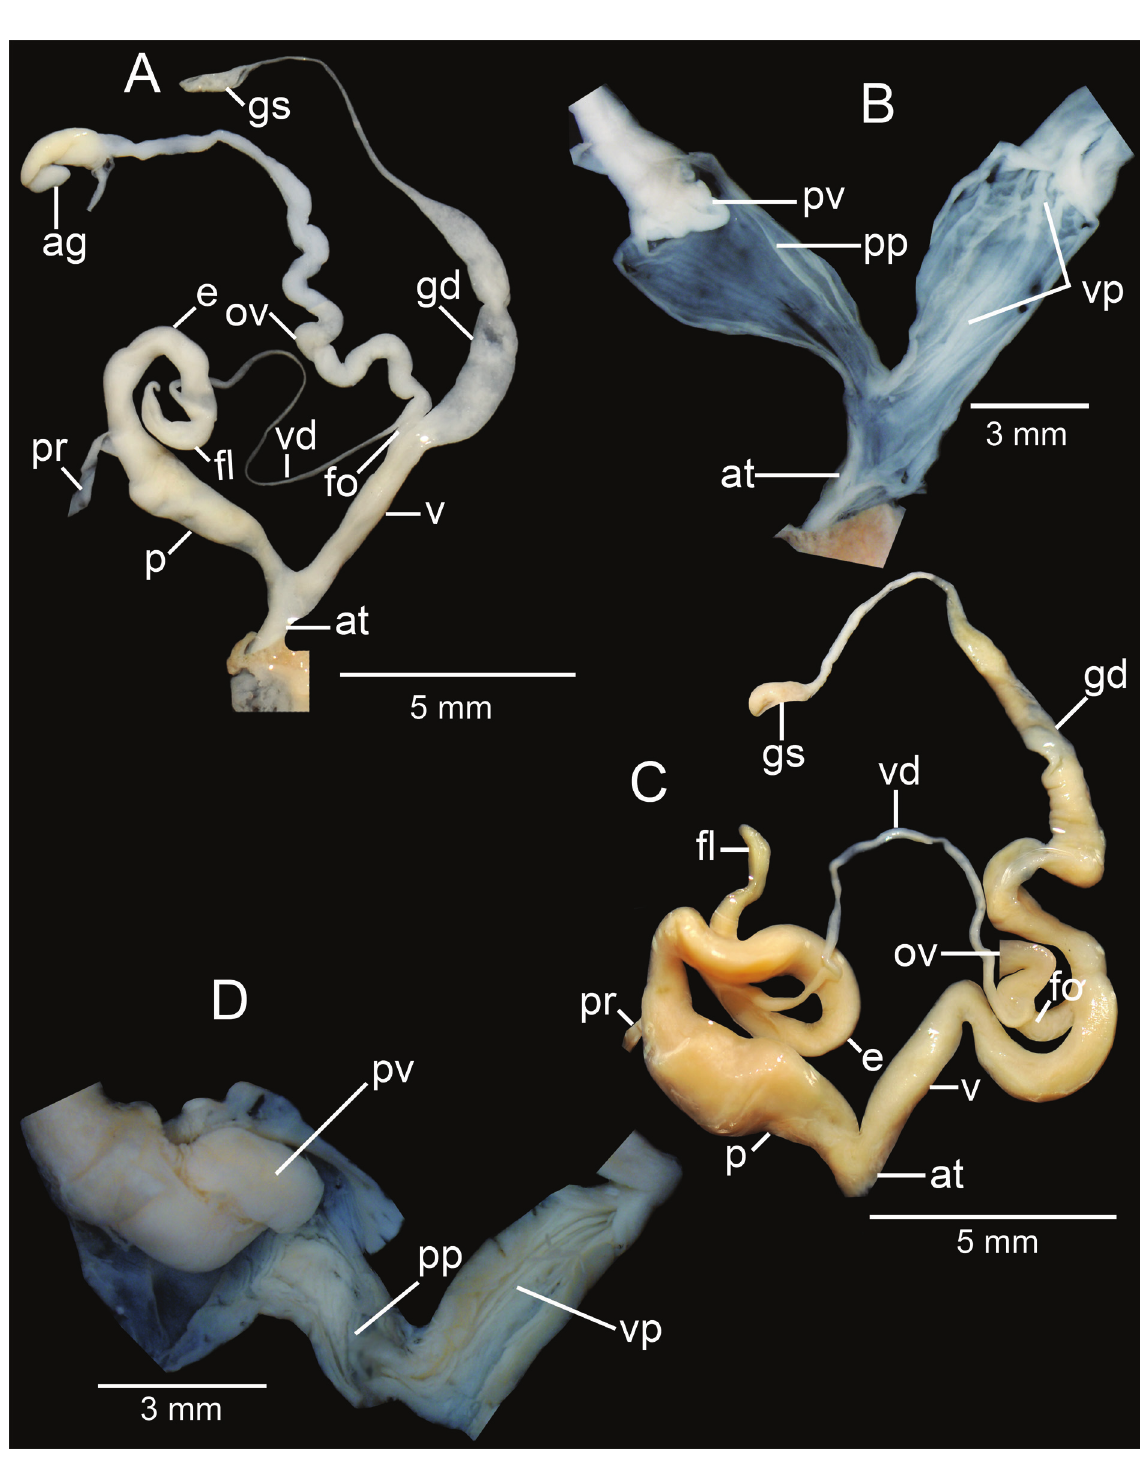
Fig. 11. Genitalia of Amphidromus ( Syndromus ) spp. A–B . Amphidromus areolatus (Pfeiffer, 1861) from Thad Fek, Attapeu, Laos showing the reproductive system and interior structures of the penis and vaginal chamber (CUMZ 7023). C–D . Amphidromus flavus (Pfeiffer, 1861) from Ban Na Deauy, Luang Phrabang, Laos showing the general characteristics of the genital system and the interior structures of the penis, atrium and vagina chamber (CUMZ